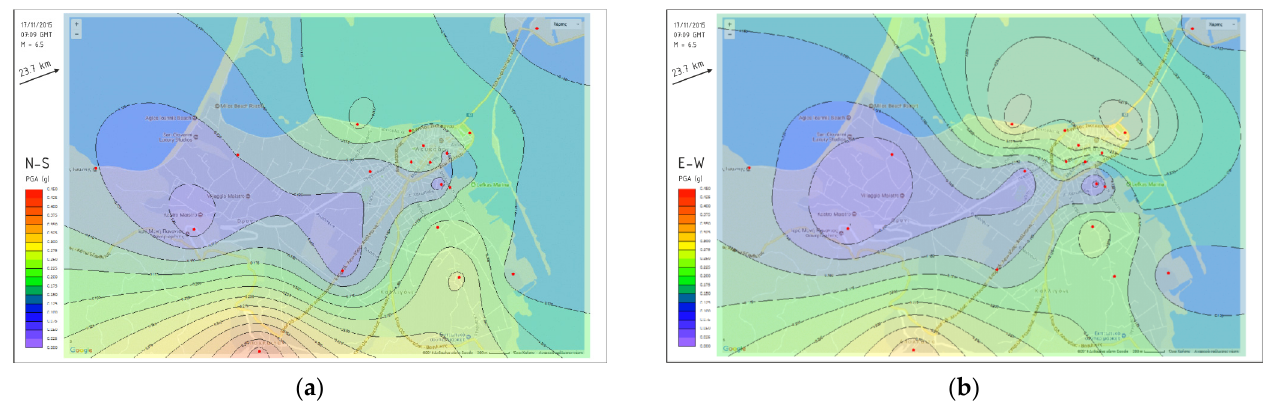
Figure 10. PGA contour maps ( a ) N-S and ( b ) E-W directions for the M6.5 Lefkada earthquake.